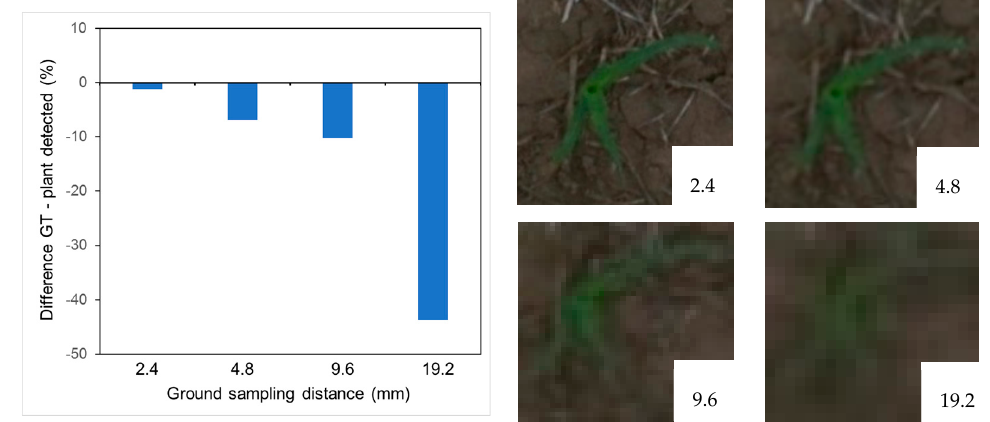
Figure 7. Difference between ground-truth and objects detected by the classifier as a function of spatial resolution.